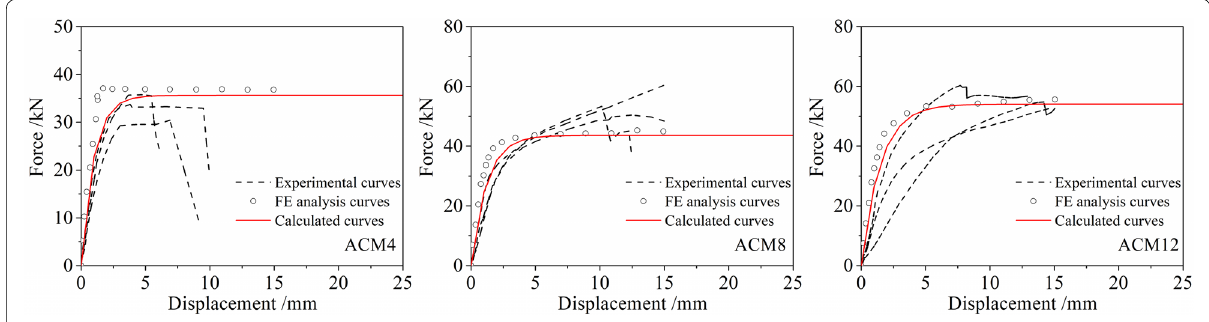
Fig. 16 Comparison of the calculated curves, experimental curves, and finite element (FE) analysis Table 6 Theoretical calculation values of the bearing capacity and elastic stiffness from the literature [6] Specimen series